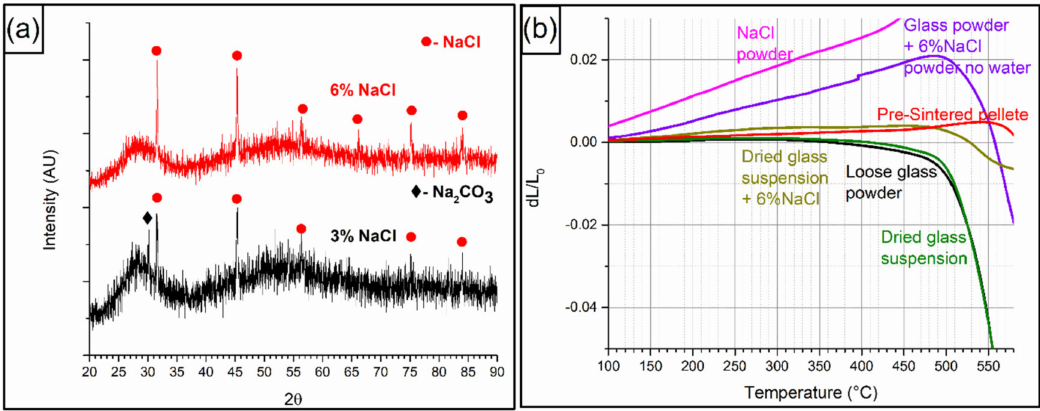
Figure 4. ( a ) XRD patterns of the coated samplesupon addition of 3 wt. % (black) and 6 wt. % NaCl (red). ( b ) Dilatometry measuremnts following di ff erent factors variation; black and red are glass in air and pre-sintered pellete redrawn from Figure 2b for a comperison; Dried glass suspention (green); dried glass suspension with 6% NaCl (yellow); glass powder with NaCl powder and no water (purple) and NaCl powder only (pink).